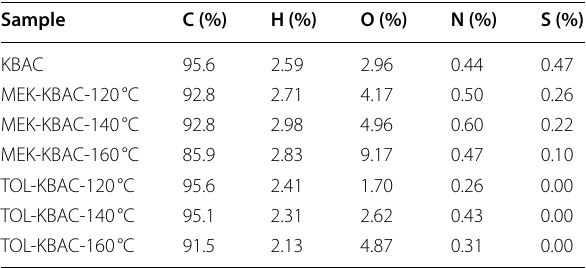
Table 1 Elemental analysis results for virgin and electrothermal regenerated